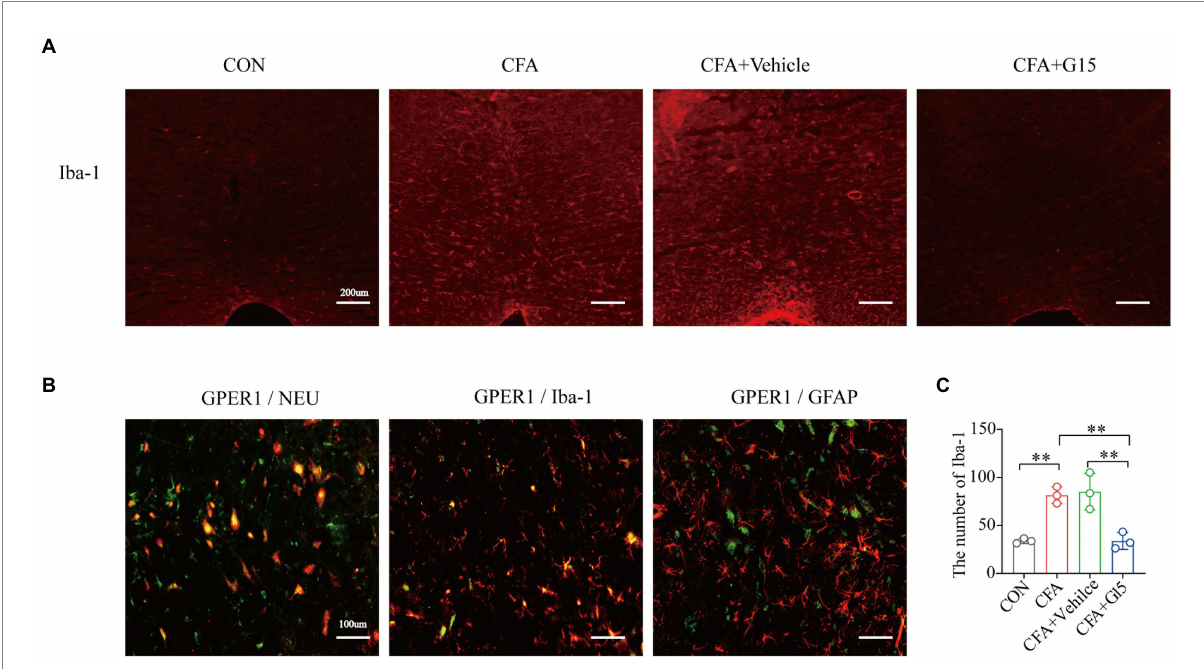
FIGURE 4 Changes of Iba-1 positive cells in RVM. Number of activated Iba-1-positive cells in the RVM under different pain states. (A) Representative immunofluorescence images showing the distribution of Iba1 labeled microglia in the RVM of different pain states. Red: microglia. (B) . GPER1 was mainly expressed in NeuN-labeled neurons in Iba 1 labeled microglia, but not in glial fibrillary acidic protein (GFAP)-labeled astrocytes at CON group. Red: Iba1 labeled microglia, Neu labeled neurons, glial fibrillary acidic protein (GFAP) labeled astrocytes. Green: GPER1 + cells. Yellow: Indicates integrated signal. (C) Number of Iba1 labeled microglia in the RVM of rats in different states. The number of Iba1 labeled microglia was significantly reduced in the CFA + G15 group compared with the CFA group, while there was no significant difference between the CFA group and CFA + Vehicle group. Data represent the mean ± SD. All statistical analysis was performed using one-way ANOVA followed by the Tukey post hoc test for multiple group comparisons. ** p < 0.01. n = 3 per